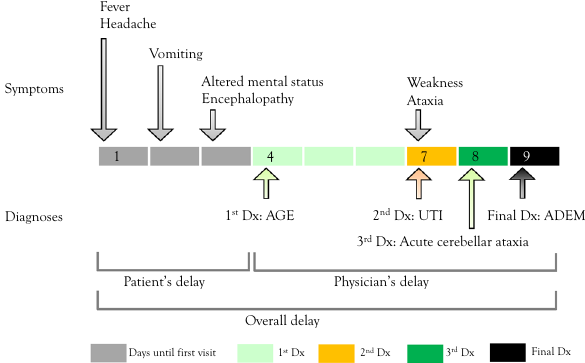
Figure 1. Example of the diagnostic odyssey plot. Patient #18 visited the physician on the fourth day after symptom onset. There were three misdiagnoses until the correct diagnosis of ADEM. Patient and physician delays were 3 and 6 days, respectively. Grey: days from symptom onset to first visit (patient delay); light green: days with the first diagnosis; orange: days with the second diagnosis; green: days with the third diagnosis; and black: day of final diagnosis (ADEM diagnosis). ADEM acute disseminated encephalomyelitis, AGE acute gastroenteritis, UTI urinary tract infection, Dx